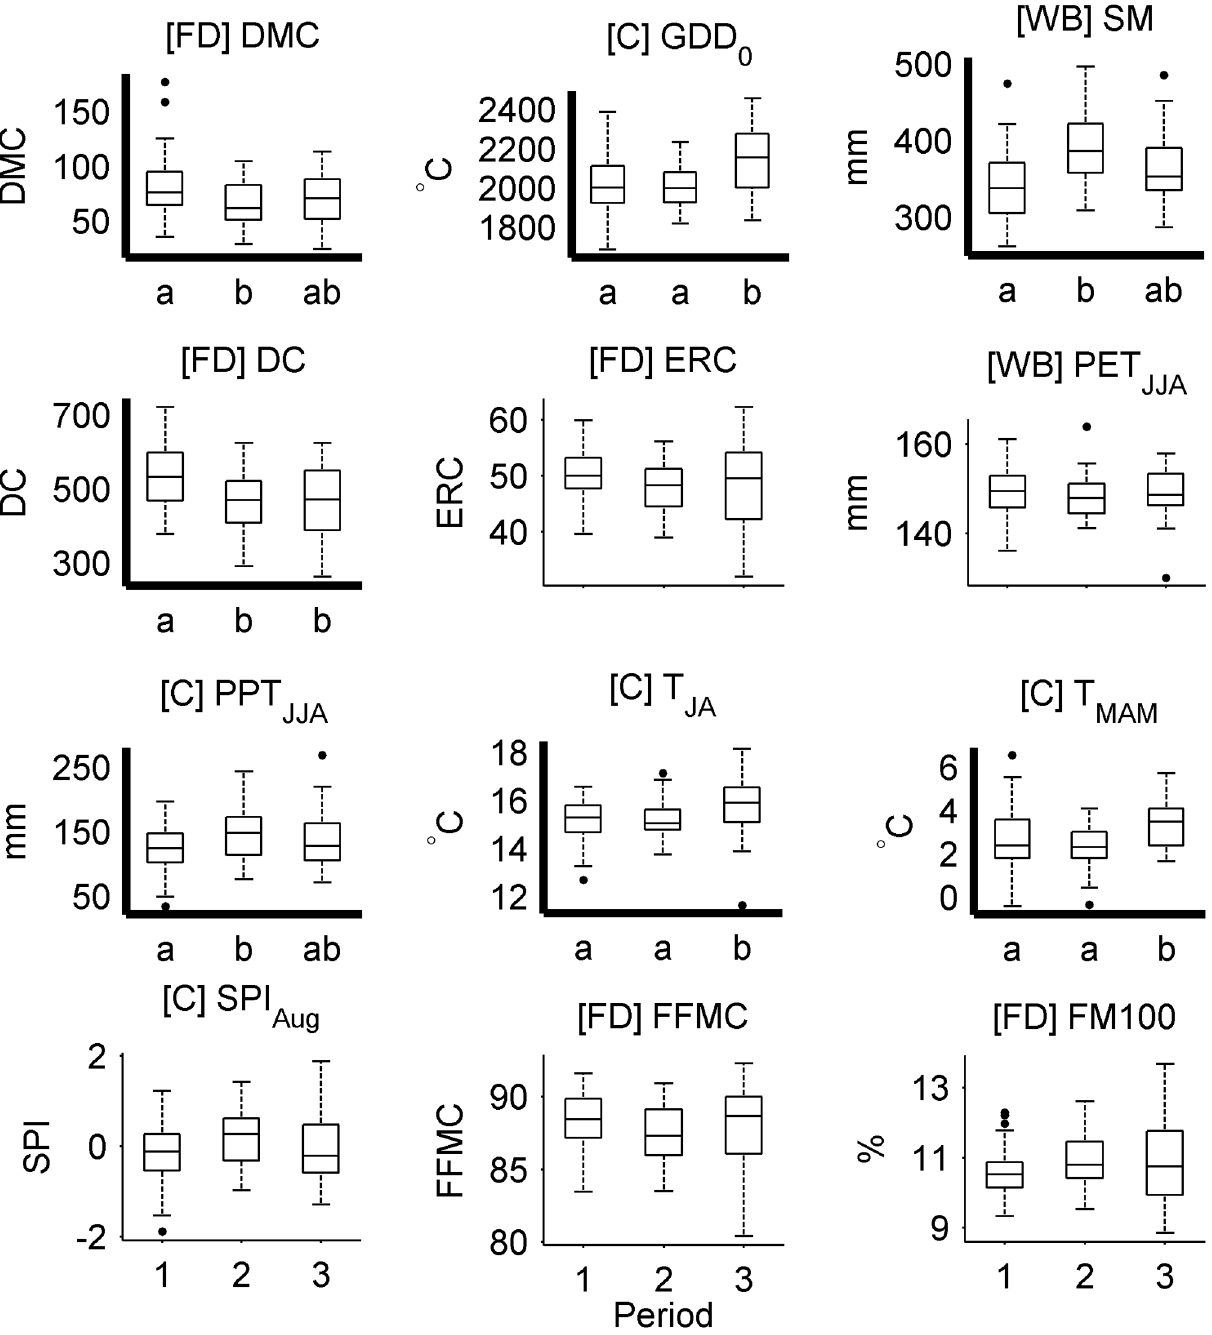
Fig 6. Variability in fire-danger, water-balance, and climate metrics across discrete periods of fire activity. Periods were identified by piecewise linear regression: Period 1 (1902 – 1942), Period 2 (1943 – 1984), Period 3 (1985 – 2008). Metrics are labeled as in Fig 3 and ordered from upper left to lower right based on the overall model score (Table 2). Metrics with significant among-period variability are highlighted with a bold x and y axis, and results of the post- hoc multiple comparison test are illustrated by lower case “ a ” “ b ” and “ c ” below the x axis. See Detecting changing fire-climate relationships ... for